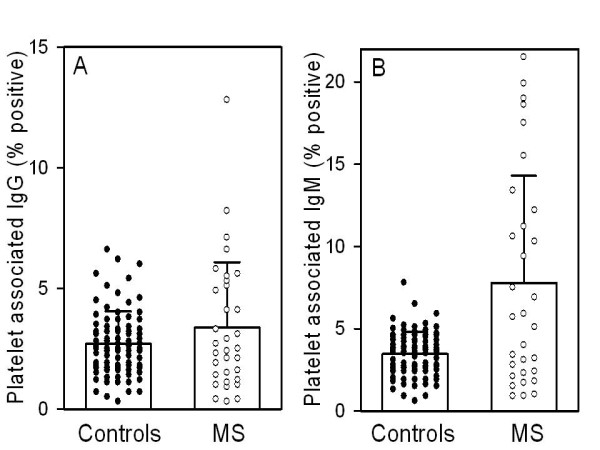
Comparison of platelet-associated IgG and IgM between controls and MS patients. Results are expressed as percentage of platelets positive for the indicated immunoglobulin, where positive is defined as >3SD above the mean for normal subjects in this laboratory by the procedure referenced in the methods section. (A) Results for platelet-associated IgG showed no significant difference between the MS group and controls. Value were, ± SD: 2.7 ± 1.3 for controls vs. 3.4 ± 2.7. (B) In contrast, mean platelet associated IgM was significantly higher in the MS group, *p < 0.01. Values were, ± SD: 3.4 ± 1.3 for controls vs. 7.8 ± 6.5 for MS. Not shown or included in analysis were 2 very high outlying values (55.9, 65.9).